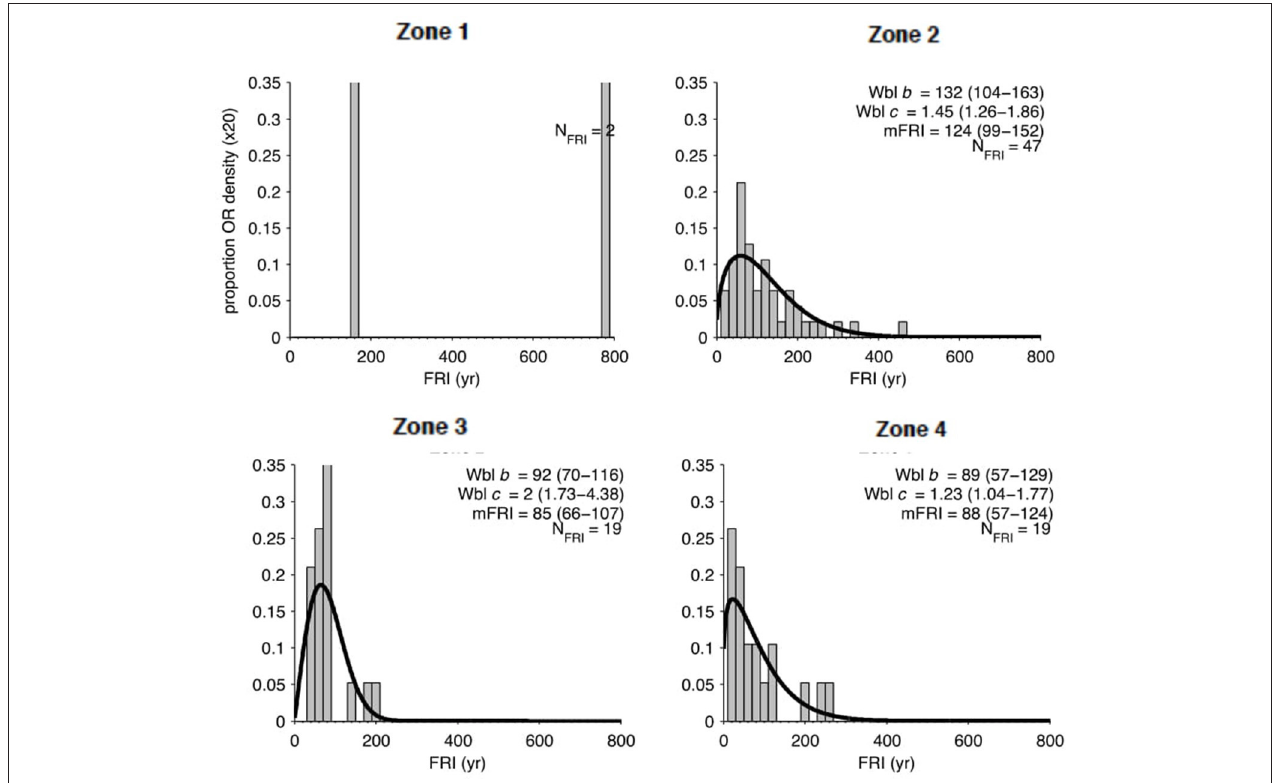
FIGURE 6 | (A) Identified charcoal peaks represented by the red plus symbol and the peak magnitude in dark blue; (B) Fire return interval with 95% confidence intervals; (C) Smoothed fire frequency (fires per 1,000 years); (D) Local signal-to-noise index throughout the record with the global signal-to-noise index